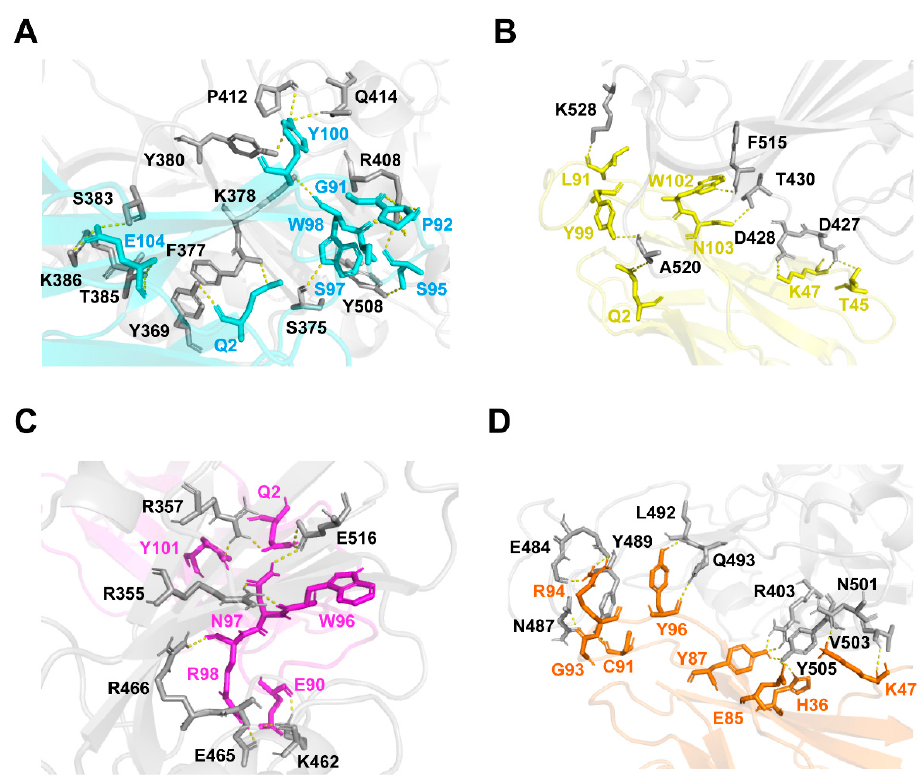
Figure 8. Binding sites of VNARs to WT SARS-CoV-2 RBD. ( A – D ) The binding sites of JM-2 ( A ), JM-5 ( B ), JM-17 ( C ), and JM-18 ( D ) to RBD. The binding residues on RBD are shown in gray. The binding residues on JM-2, JM-5, JM-17, and JM-18 are shown in cyan, yellow, magenta, and orange, respectively.